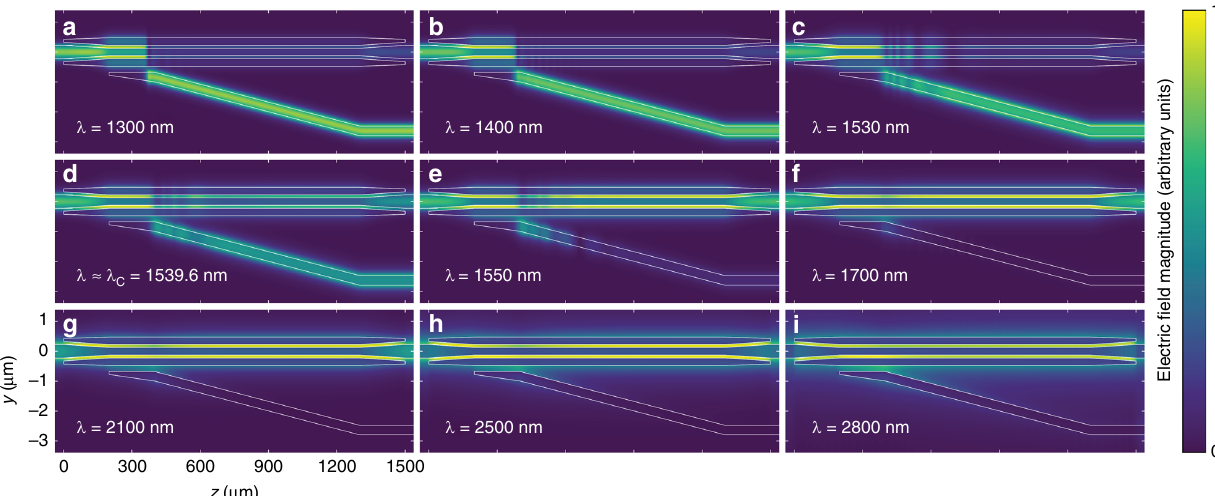
Fig. 4 Simulated light propagation in the designed adiabatic transitions. a – c For wavelengths shorter than the cutoff ( λ < λ C ), majority of the input light reaches the bottom output port. d Input is evenly distributed between the two outputs at cutoff λ C = 1539.6 nm. e – i Light remains in the top waveguide and is output through the top port for longer wavelengths ( λ > λ C ), demonstrating the estimated octave-wide bandwidth from 1300 to 2800 nm by